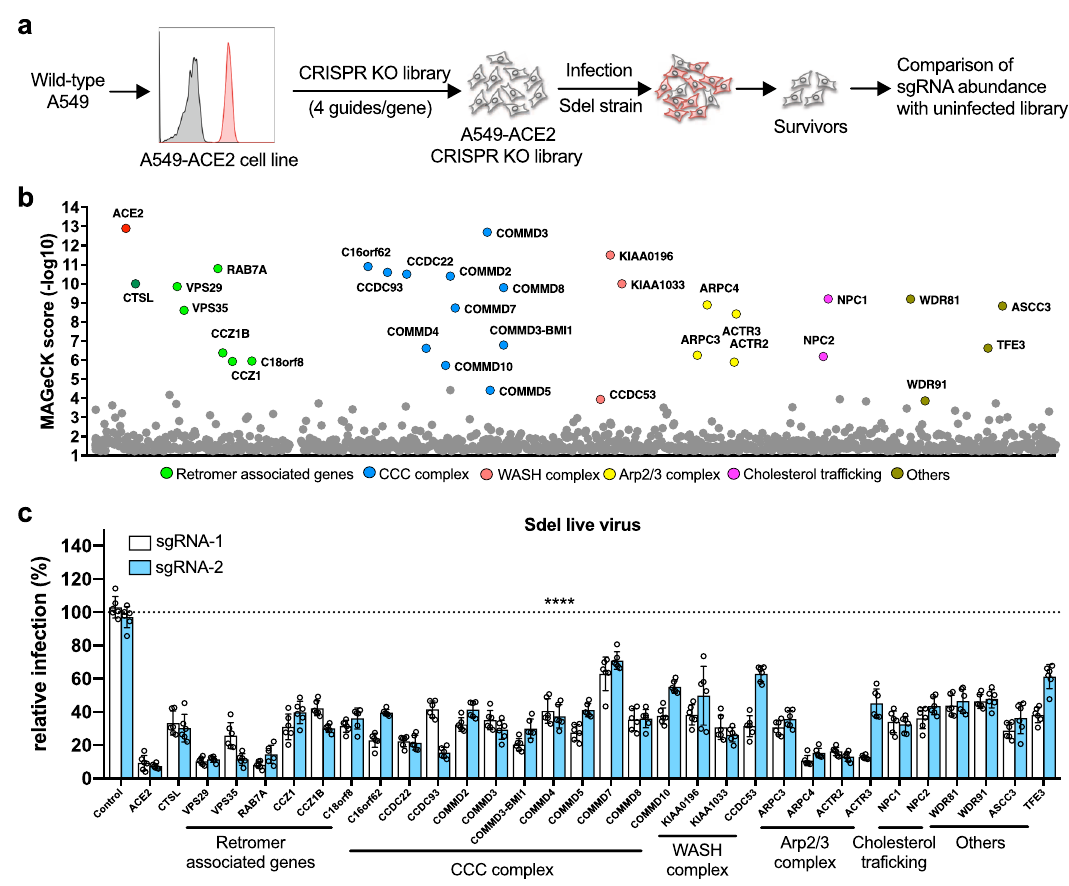
Fig. 2 Genome-wide CRISPR/Cas9 screen identi fi es host factors using Sdel virus as model. a Schematic of the screening process. A549 cells expressing the human ACE2 were used to generate the CRISPR sgRNA knockout cell library. The library was infected with Sdel strain of SARS-CoV-2, and cells survived were harvested for genomic extraction and sequence analysis. b Genes and complexes identi fi ed from the CRISPR screen. The top 32 (FDR < 0.15) genes were indicated based the MAGeCK score. c The top 32 genes were selected for experimental validation in A549-ACE2 cells using two independent sgRNAs by Sdel live virus infection. Data shown are an average of two independent experiments performed in triplicate and are normalized to the controls of individual experiments. One-way ANOVA with Dunnett ’ s test; n = 6; mean ± s.d.; **** P <